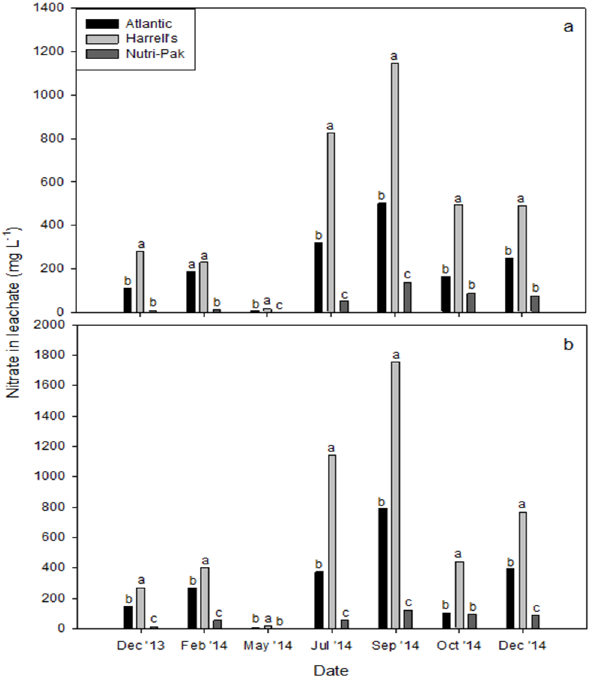
Figure 2. Nitrate leached from potting medium supporting Livistona chinensis ( a ) and Syagrus romanzoffiana ( b ) plants during 17 months of growth with Atlantic, Harrell’s or Nutri-Pak fertilizer. Letters above bars for an individual date represent mean separation by Tukey’s at 0.05